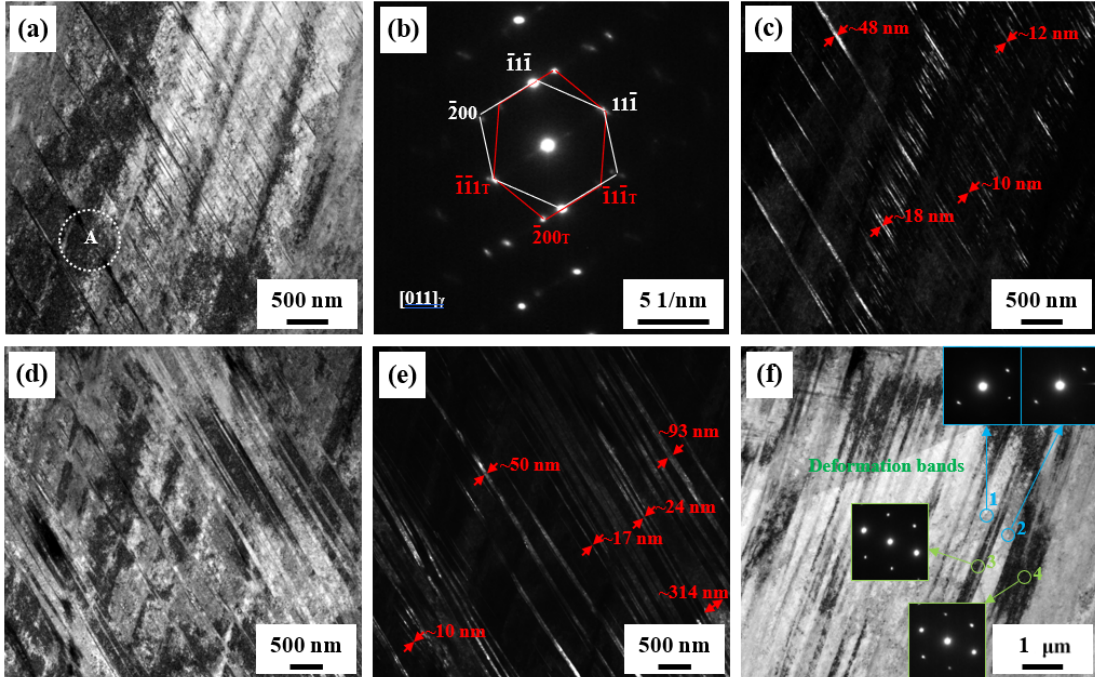
Figure 6. TEM images of typical microstructures of the steel after tensile deformation at 77 K. ( a , d ): Bright-field TEM images, exhibiting clear contrast of mechanical twins. ( b ) SAEDP of the outlined region A in ( a ). ( c , e ): Corresponding dark-field (cid:0) (cid:1) TEM images obtained from the 111 reflection in ( b ). ( f ) Bright-field TEM image, showing deformation bands. The insets T in ( f ) are SAEDPs of the outlined regions 1–4 in ( f